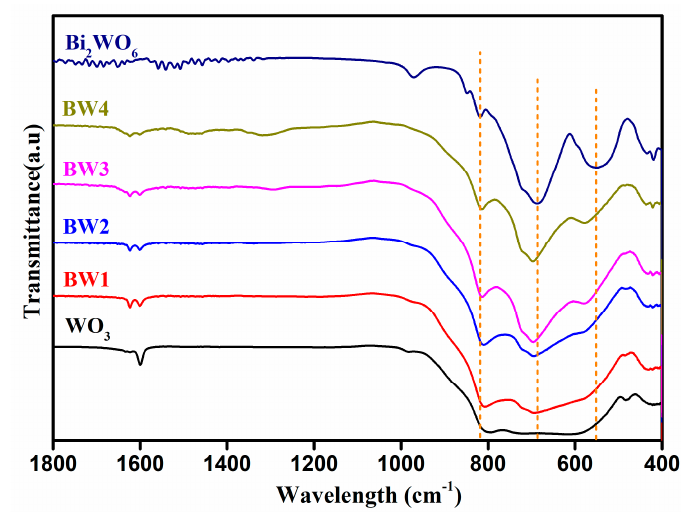
Figure 2. Fourier transformation infrared spectra (FT-IR) spectra of pure WO 3 , Bi 2 WO 6 , and Bi 2 WO 6 /WO 3 samples.